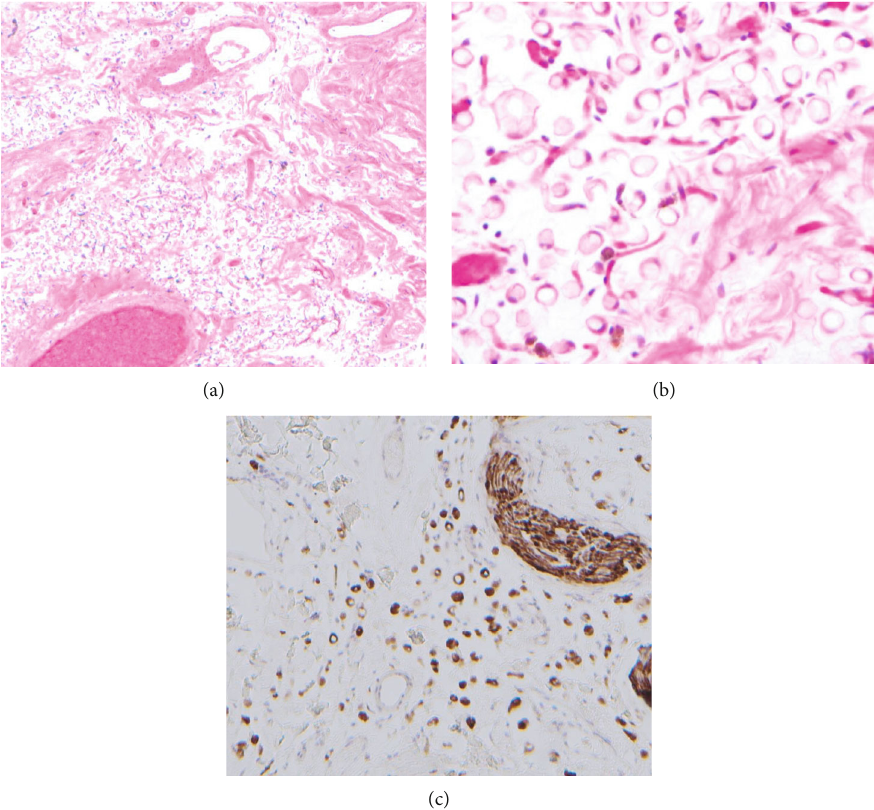
Figure 1: (a, b) The subserosal tissue exhibits a prominent population of signet ring-like cells, associated with oedema and a delicate capillary network. (c) The signet ring-like cells show strong nuclear and cytoplasmic positivity for S100 protein. A small nerve (upper right) is also reactive for S100